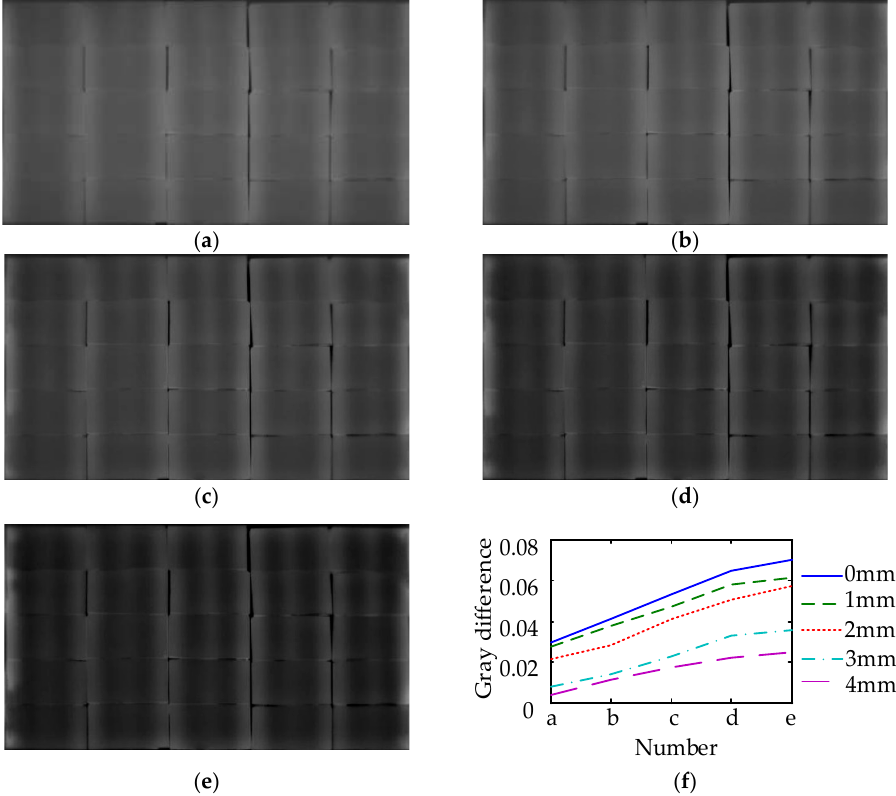
Figure 21. Results of fusion enhancement. ( a ) Results of fusion enhancement (thermal images of 15 s and 15 s); ( b ) results of fusion enhancement (thermal images of 12 s and 18 s); ( c ) results of fusion enhancement (thermal images of 9 s and 21 s); ( d ) results of fusion enhancement (thermal images of 6 s and 24 s); ( e ) results of fusion enhancement (thermal images of 3 s and 27 s); ( f ) relationship between the number of fusion enhancement and the gray scale difference.